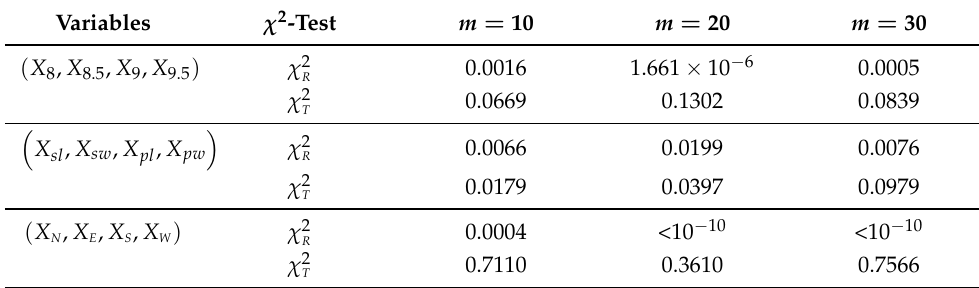
Table 2. p -values from the two chi-squared